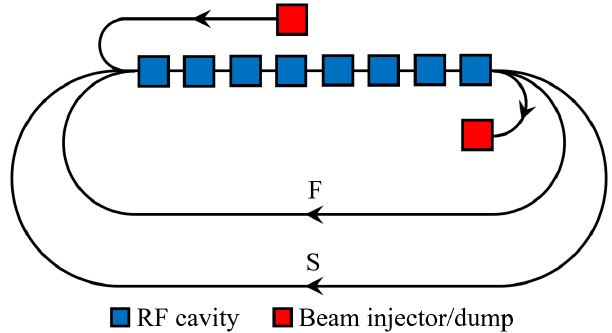
FIG. 2. The S-DALINAC facility scheme (twice recirculating ERL mode) used in this